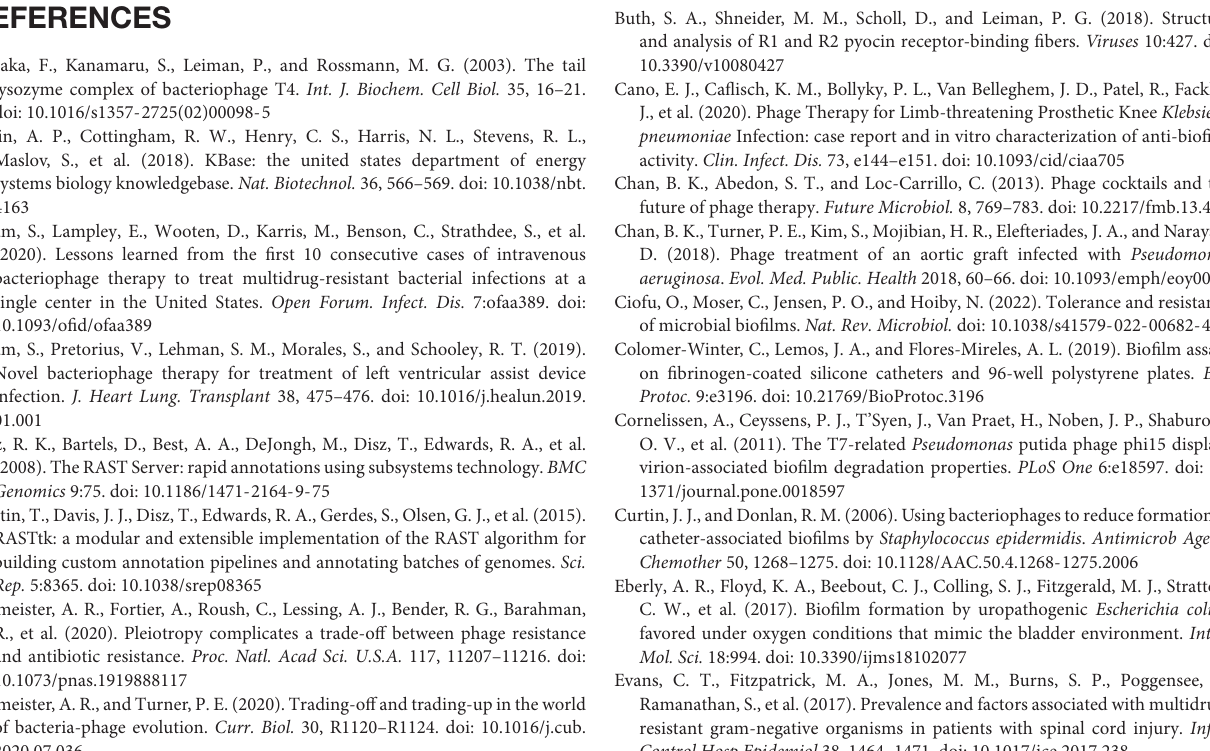
Supplementary Figure 1 | Activity of phage cocktails against E. coli isolated from the urine of patients with SCI. Viability of cells in the biofilm under each condition after 24-h treatment with 10 7 PFU/mL of phage cocktails is represented as a percentage of the untreated control. Biofilms of E. coli DS457, DS517 and DS549 in TSB (A) and human urine (B) are shown. ∗∗∗ p < 0.001, ∗∗ p < 0.01, ∗ p < 0.05. Supplementary Figure 2 | MAFFT alignment of the amino acid sequence of the distal tail-fiber protein with putative endosialidase activity identified in phage included in the anti-biofilm phage cocktails. An identity histogram is shown at the top: green represents 100% identity across samples, greeny-brown represents between 30 and 100% identity, and red represents < 30% identity. Black lines represent amino acid differences from the majority